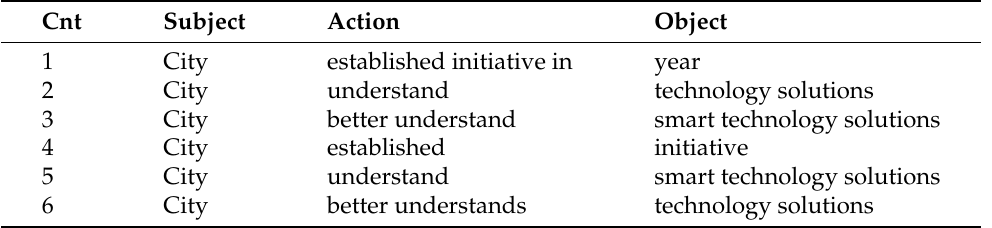
Table 1. Example triplets generated from a sentence using the Open IE algorithm in the Stanford CoreNLP